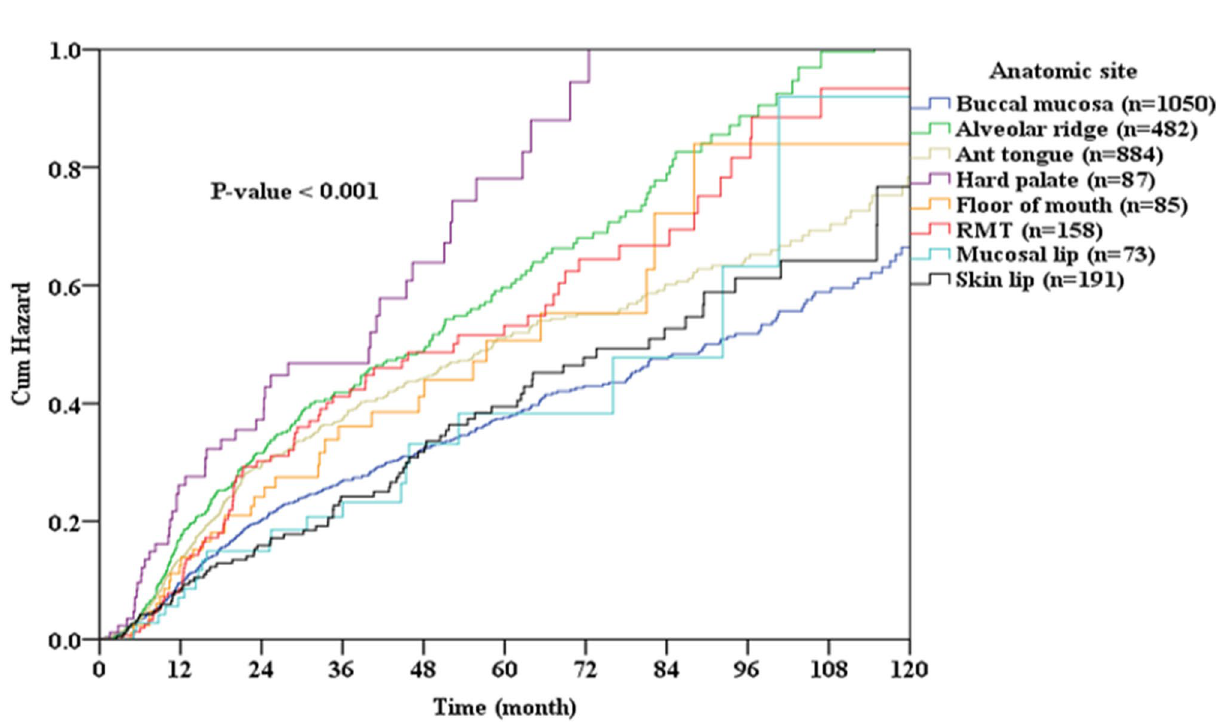
Figure 2. Cumulative rate of cancer-related death among patients with oral cavity squamous cell carcinoma (OSCC) according to location of